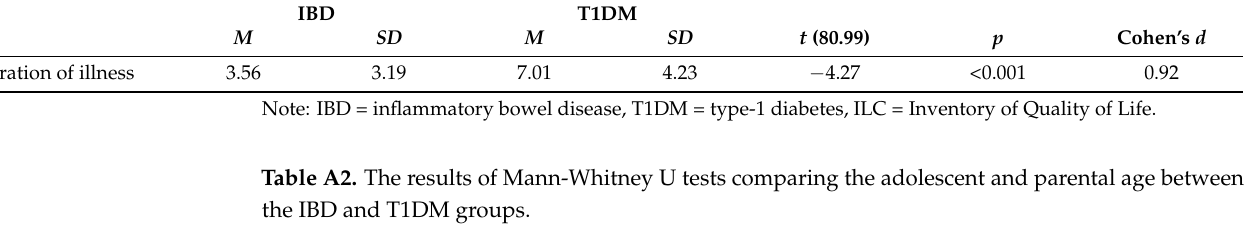
Table A1. Difference between adolescents diagnosed with IBD and T1DM in the duration of illness. IBD T1DM M SD M